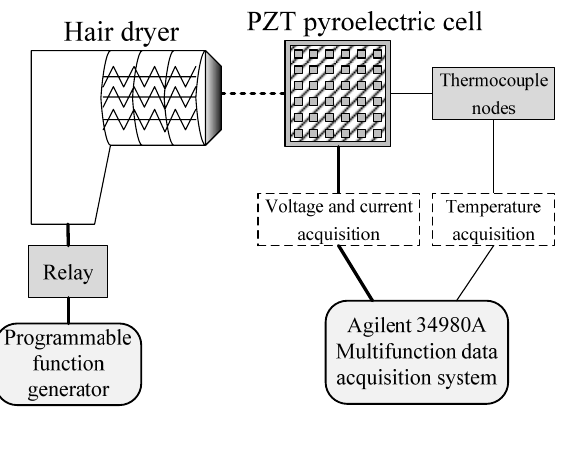
Figure 6. Schematic diagram of the measurement experiment.